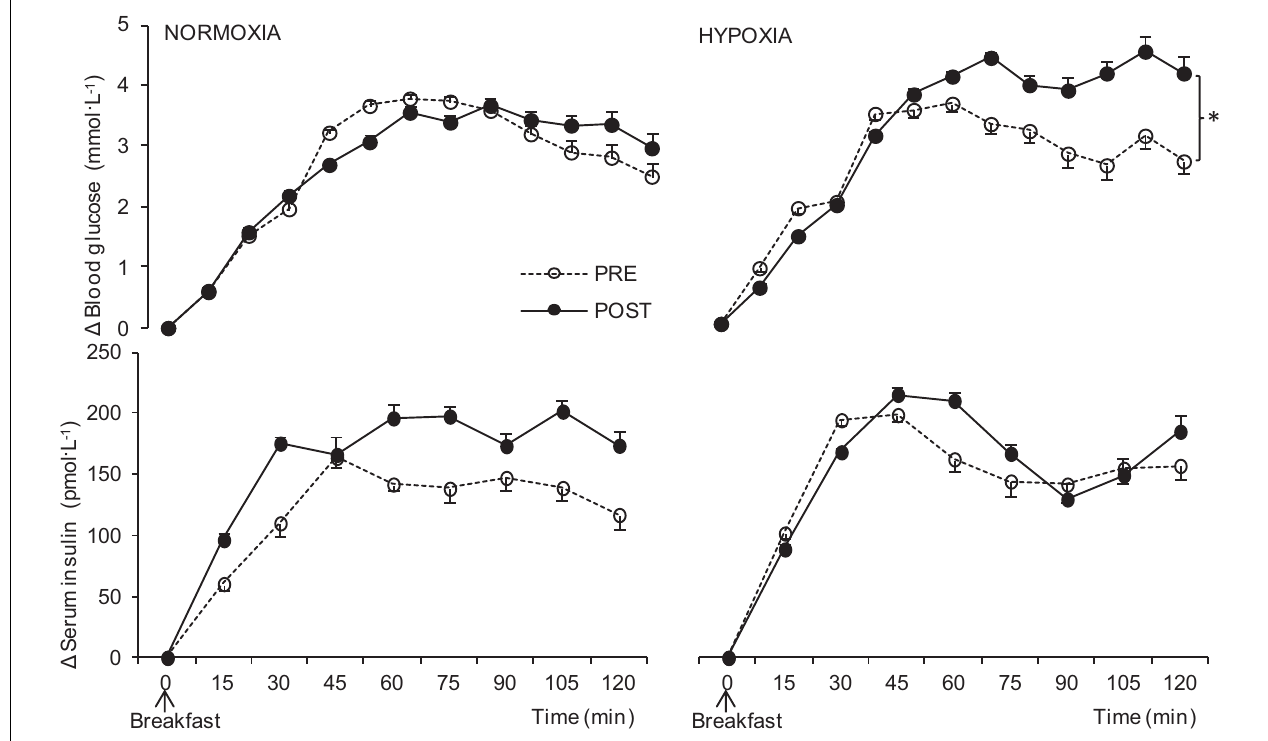
0.00.20.40.60.81.01.21.4